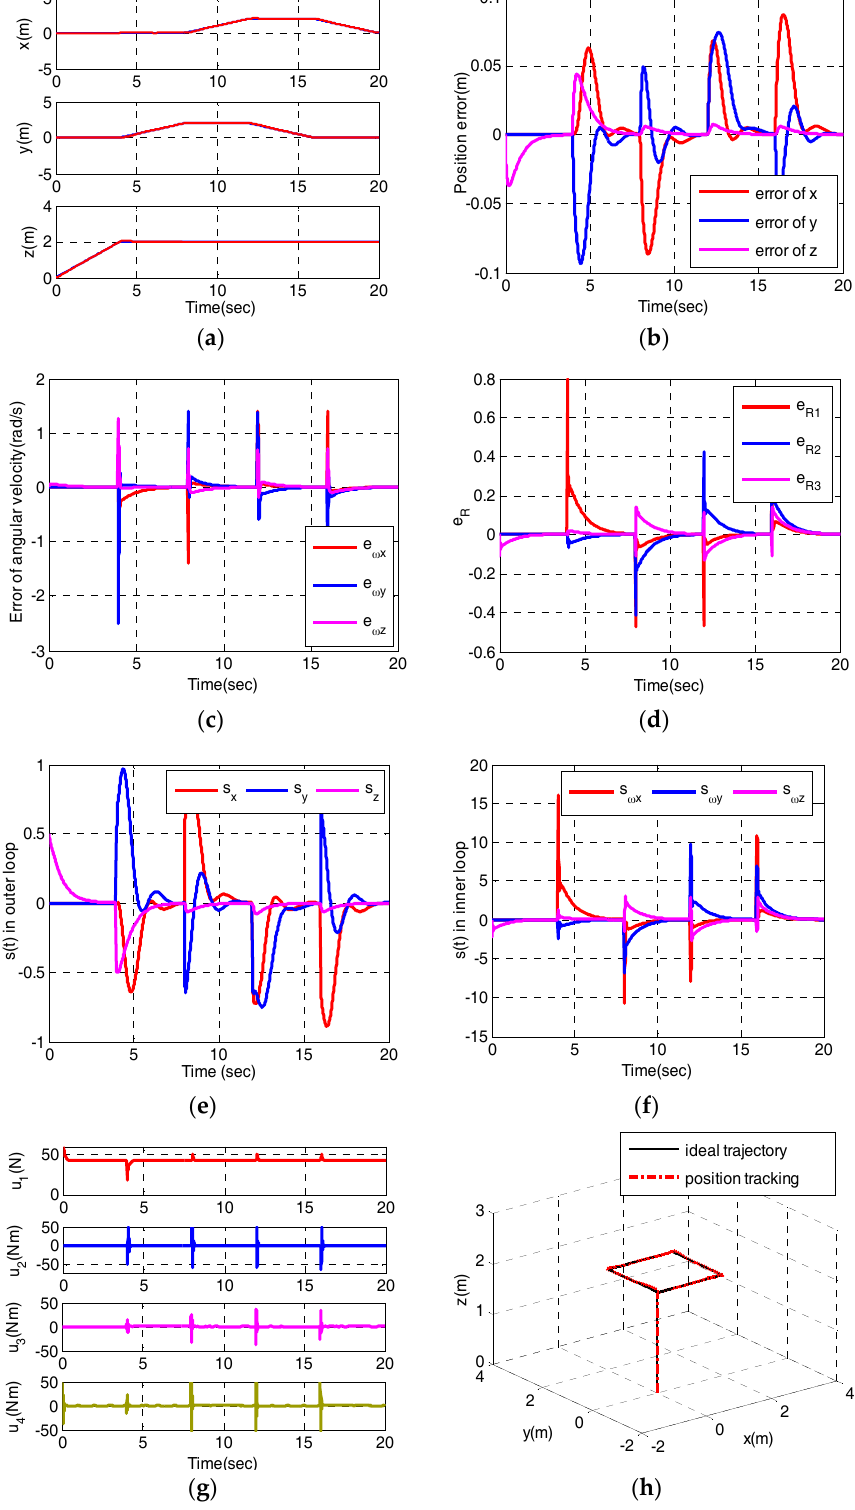
Figure 6. Tracking rectangular trajectory simulation ( a ) Position; ( b ) Error of position; ( c ) Error of angular velocity; ( d )Vector form of attitude error; ( e ) The sliding variables in outer loop; ( f ) The sliding variables in inner loop; ( g ) The control variables; ( h ) The desired trajectory and the actual trajectory in the simulation.